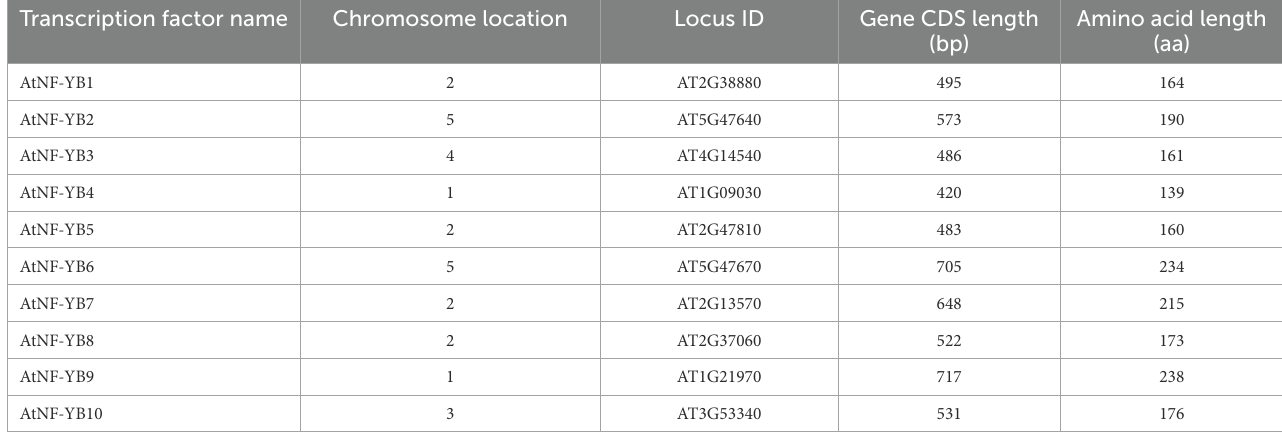
TABLE 1 Characteristics of Arabidopsis thaliana NF-YB genes: chromosome location, locus ID and basic sequence